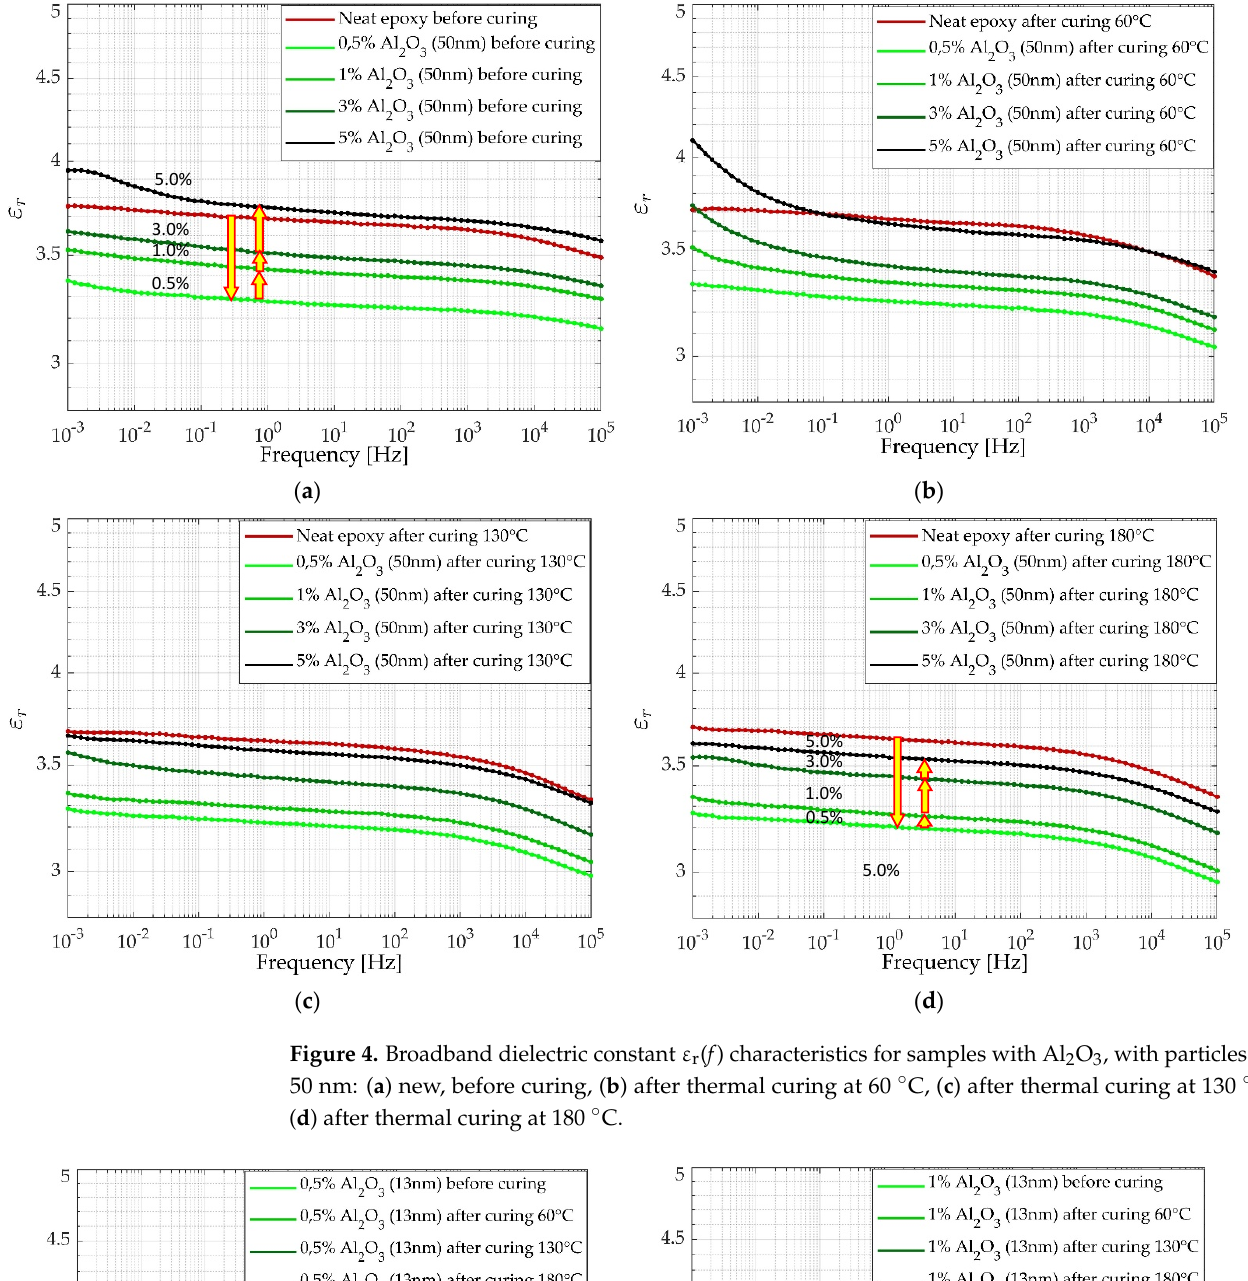
Figure 4. Broadband dielectric constant ε r ( f ) characteristics for samples with Al 2 O 3 , with particles of 50 nm: ( a ) new, before curing, ( b ) after thermal curing at 60 °C, ( c ) after thermal curing at 130 °C, ( d ) after thermal curing at 180 °C.